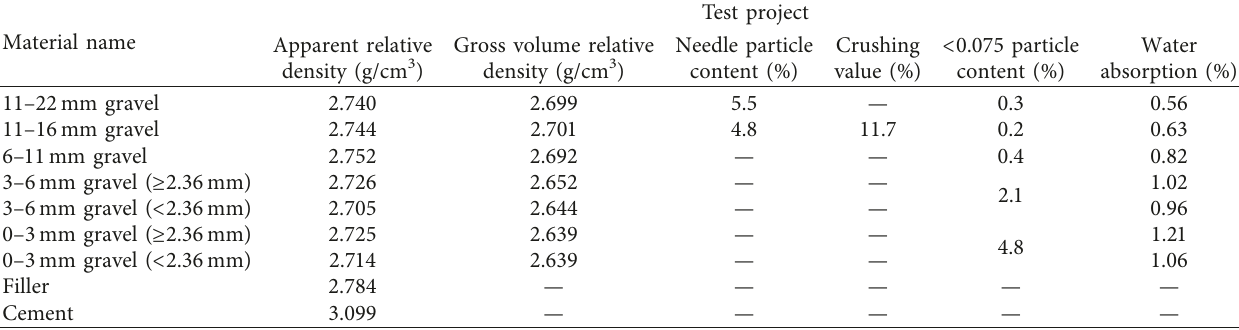
Table 2: Aggregate physical and mechanical indicators.